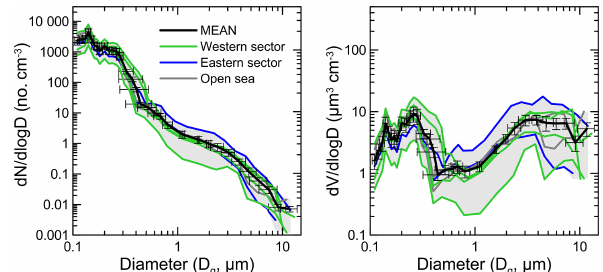
Figure 4. Number size distributions (left panel) and volume size distributions (right panel) measured over the different SLRs for the TRAQA flights. Data correspond to measurements performed within the boundary layer at altitudes < 350m (V19_R1, V21_R1, V21_R3, V23_R2, V27_R1, V31_R1, V32_R1, V32_R3). Data are separated based on the different air mass origin (Western sector, Eastern sector, and Open sea). Concentrations are given at ambi- ent conditions. Grey shading represents minimum and maximum measured values, while the black curve is the average size. Mea- surement uncertainties are also reported for the average